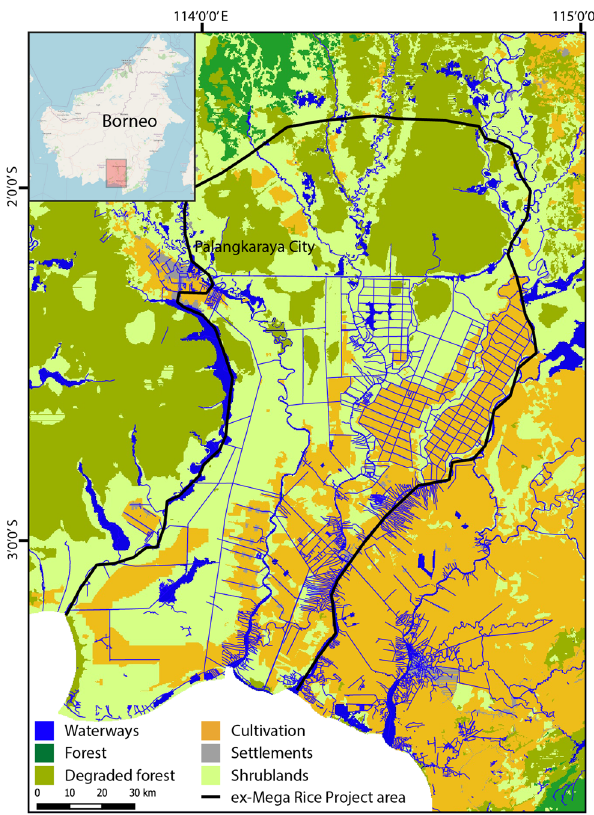
Fig. 1 Study area map. Land cover map showing the whole study area (edge of map) circa 2015 as well as the ex-Mega Rice Project (EMRP) area (black outline). Inset map of Borneo provided by